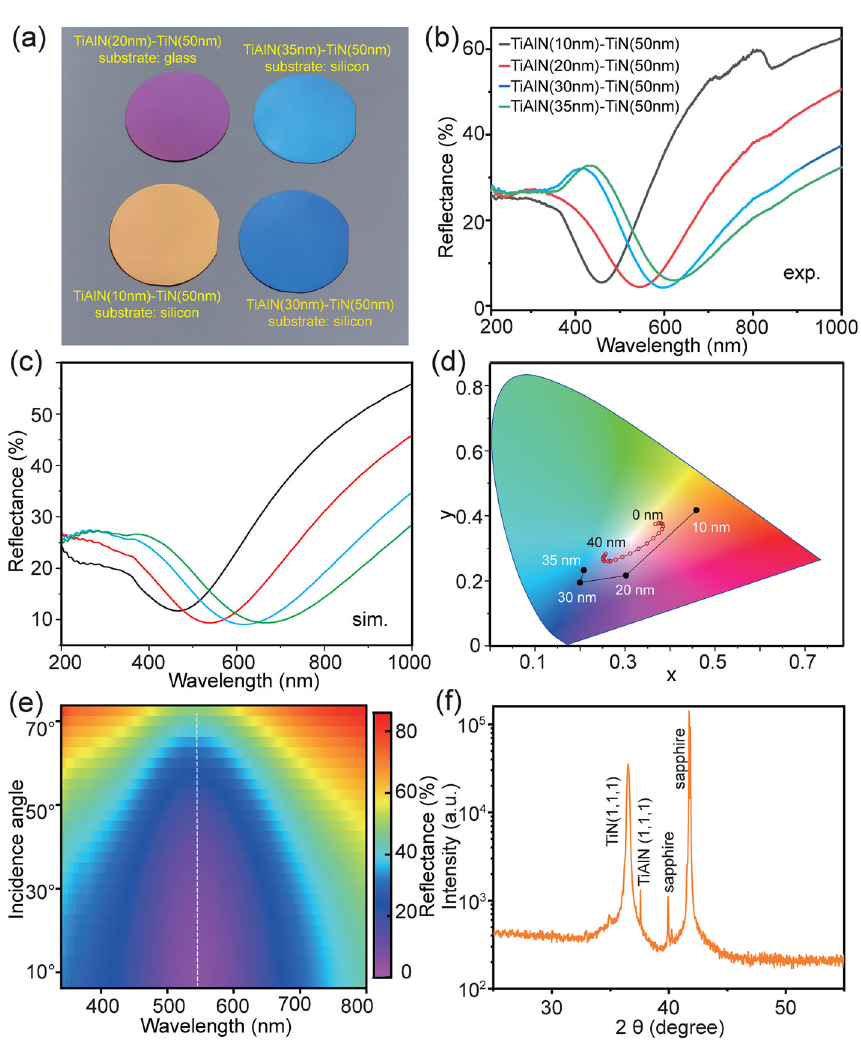
Fig. 2 a Photograph of 50 nm TiN coating with various thickness of TiAlN films. The surface coloring is insensitive to the substrate materials. Experimentally measured ( b ) and numerically simulated ( c ) reflectance spectra at normal incidence. d Chromaticity of experimentally measured (black dots) and numerically simulated spectra (red dots) on the CIE 1931 color space. In simulation, the thickness of TiAlN increases from 0 to 40 nm with a step of 2 nm. e Experimentally measured reflectance spectra with oblique incidence. The sample is 20-nm-TiAlN on a 50-nm-TiN film. The dashed line indicates the absorption dips at various incidence angles. f X-ray diffraction spectrum of a 20-nm-thick TiAlN on a 50-nm-thick TiN deposited on a sapphire substrate